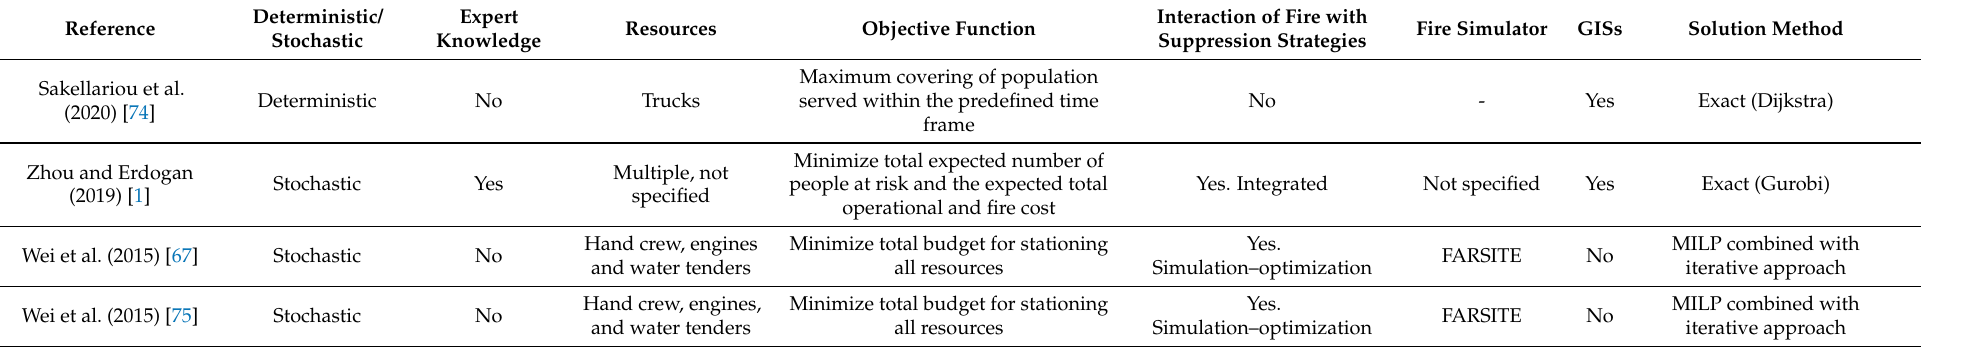
Table A8. List of main characteristics of papers that address preparedness and response. (Continues table from previous